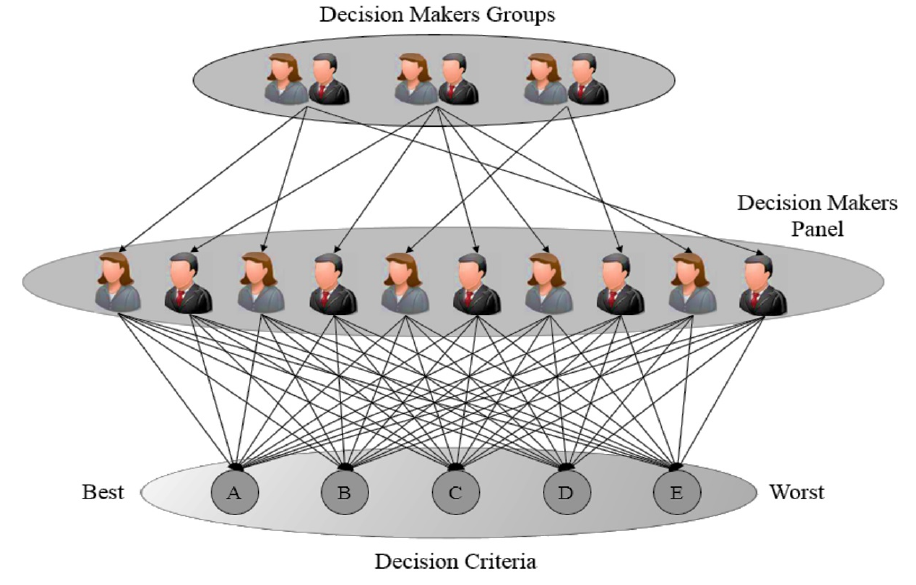
Figure 1. Decision maker